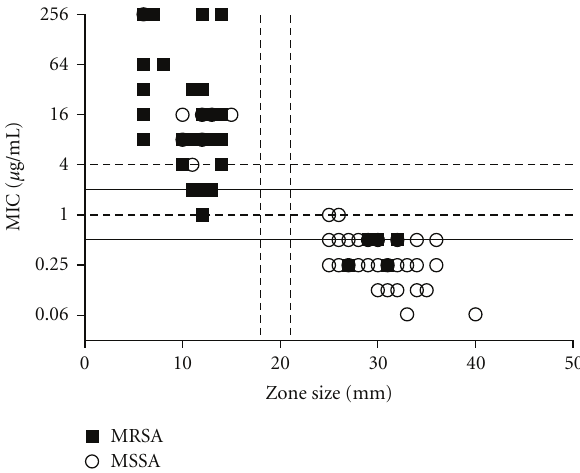
Figure 1: Semi log scatterplot of fusidic acid MIC and zone size. MIC is shown on a log(2) scale. Horizontal dashed lines (---) correspond to the MIC interpretive criteria of Jones et al., and solid lines (-) correspond to MIC interpretive criteria of Skov et al. Vertical dashed lines (---) correspond to zone diameters of 18 mm and 21mm proposed by Skov et al. MRSA ( (cid:2) ) and MSSA ( (cid:6) ) isolates are